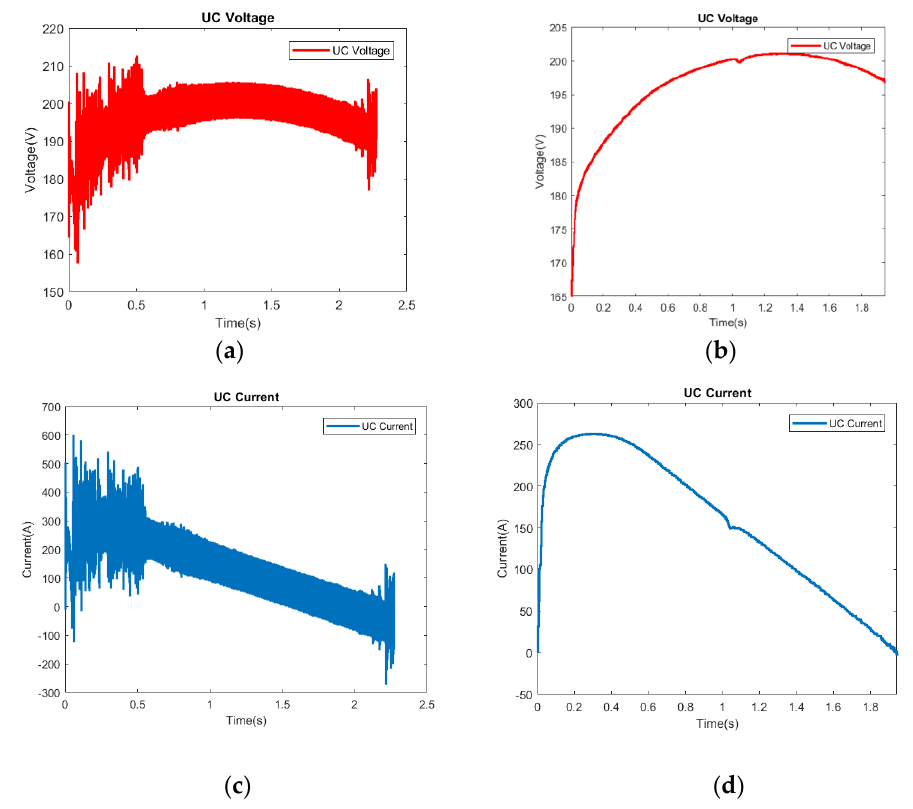
Figure 19. Voltage and charging current of the UC for the Z-source topology ( a , c ) and for the 3-level/SVPWM topology ( b , d ).